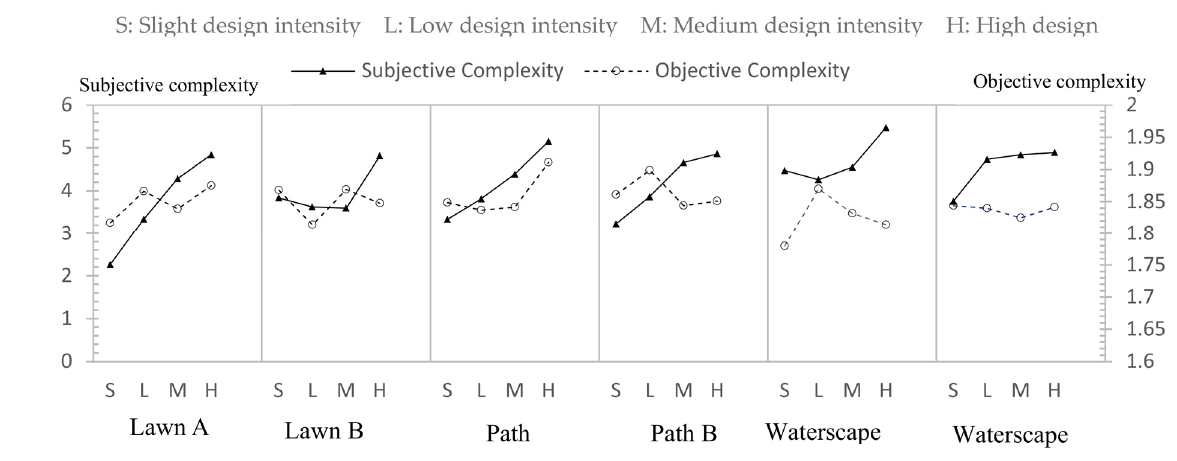
Figure 2. Objective and subjective landscape complexity for each image. Table 1. Correlations between landscape design intensity and complexity in each group and type of